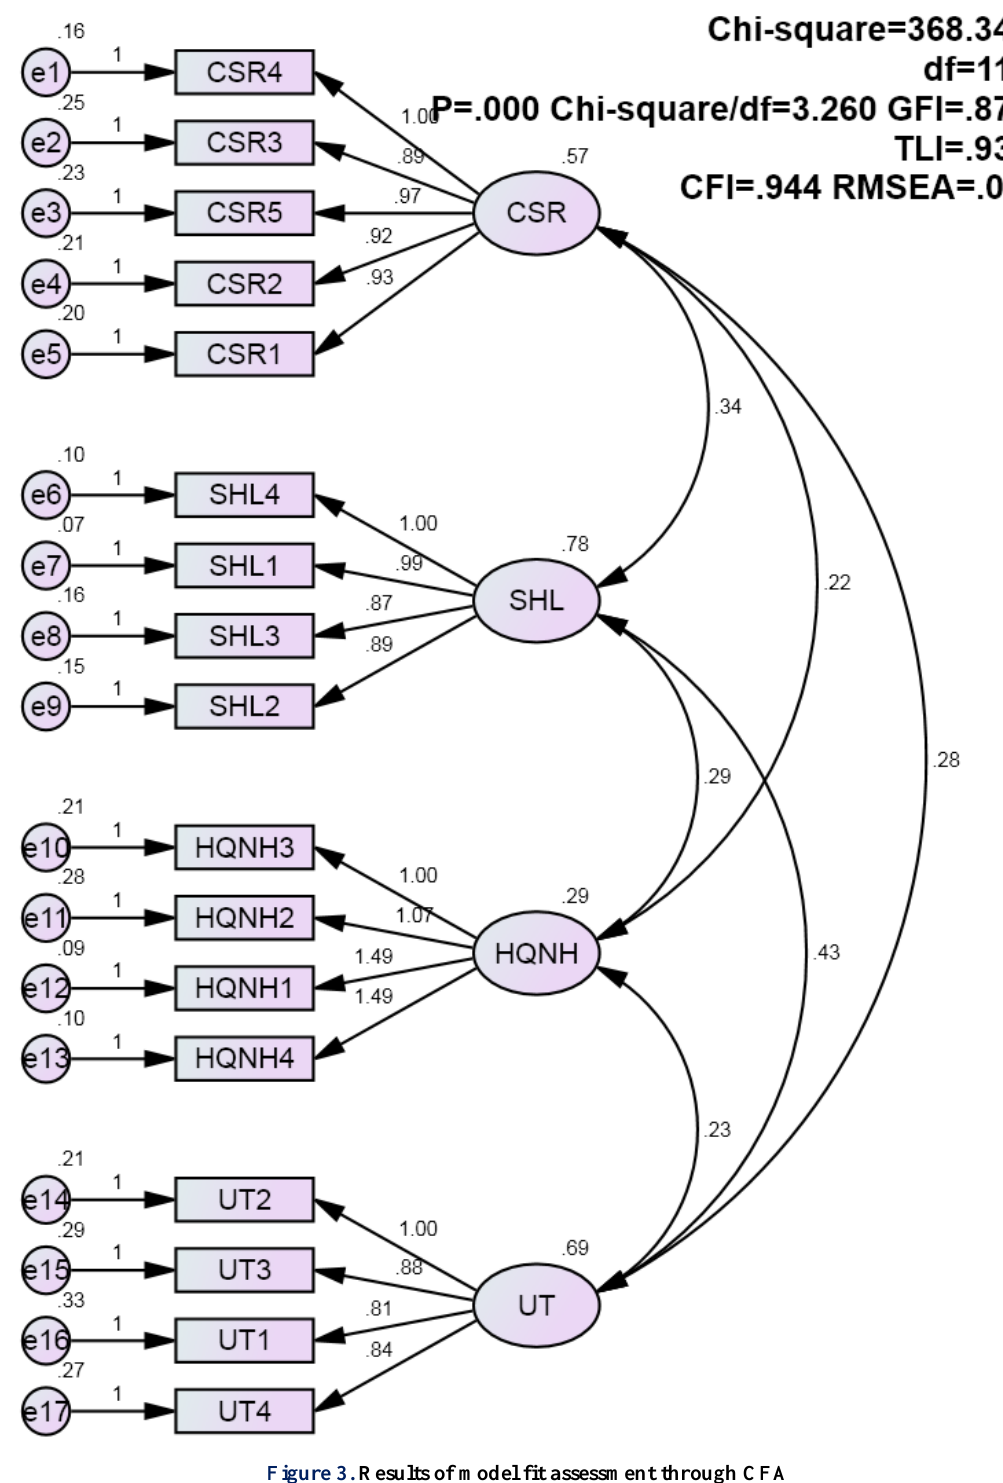
Figure 3. Results of model fit assessment through